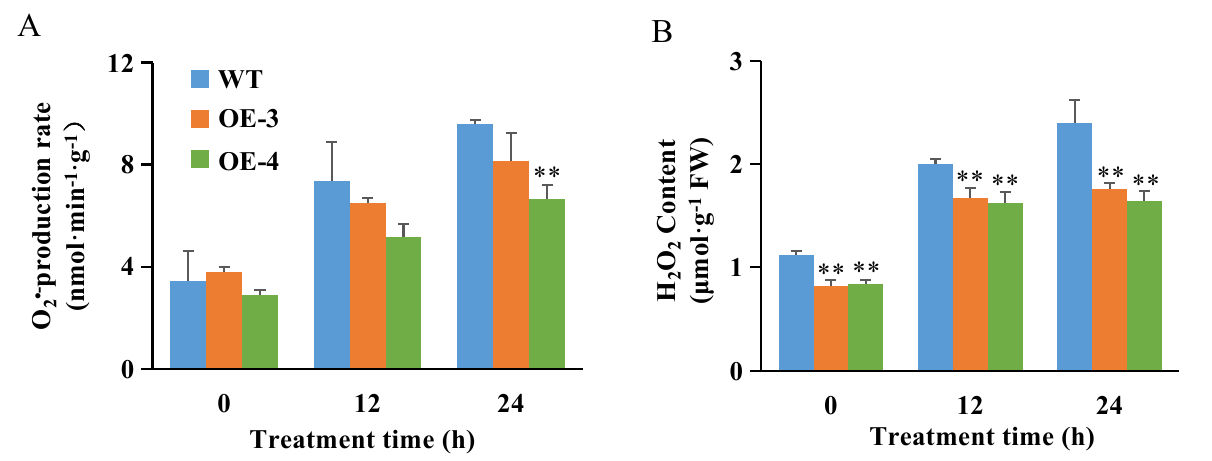
Figure 2. Changes of reactive oxygen species (ROS) in roots of various rice plants under salt stress. O 2 •− production rate ( A ) and H 2 O 2 content ( B ) in roots of two–week–old OsABT–OE lines (OE–3 and OE–4) and WT plants under 200 mM NaCl for 0, 12, and 24 h. Data are means ± SD of three independent experiments. Asterisks indicate significant differences compared to WT plants at ** p < 0.01 (Student’s t –test).